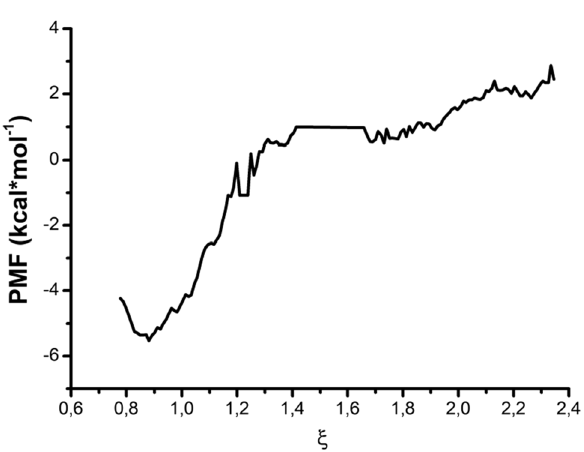
Figure 1. The complexes of compound 27 in the active site of M. tuberculosis MetRS ( a ) and LeuRS ( b ), obtained with molecular docking. Hydrogen bonds are shown by the green dotted lines, sulfur–π interaction is presented by the yellow dotted line and hydrophobic interactions are indicated by magenta colors.